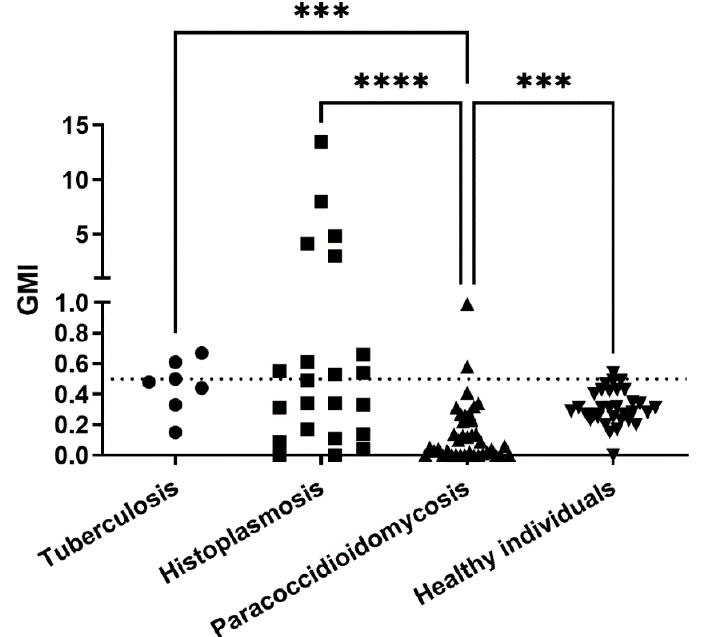
Figure 4. Galactomannan indexes of 100 individuals without aspergillosis tested with the IMMY s ō na AGM lateral flow assay. The dotted line represents the cut-off recommended by the manufacturer. Significant differences, tested by the Dunn’s multiple comparison test, are represented. *** p < 0.001, **** p <0.0001, GMI = galactomannan index.